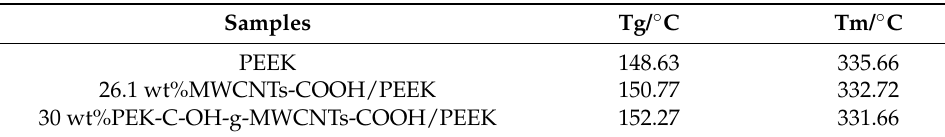
Table 4. Tg and Tm of MWCNTs/PEEK